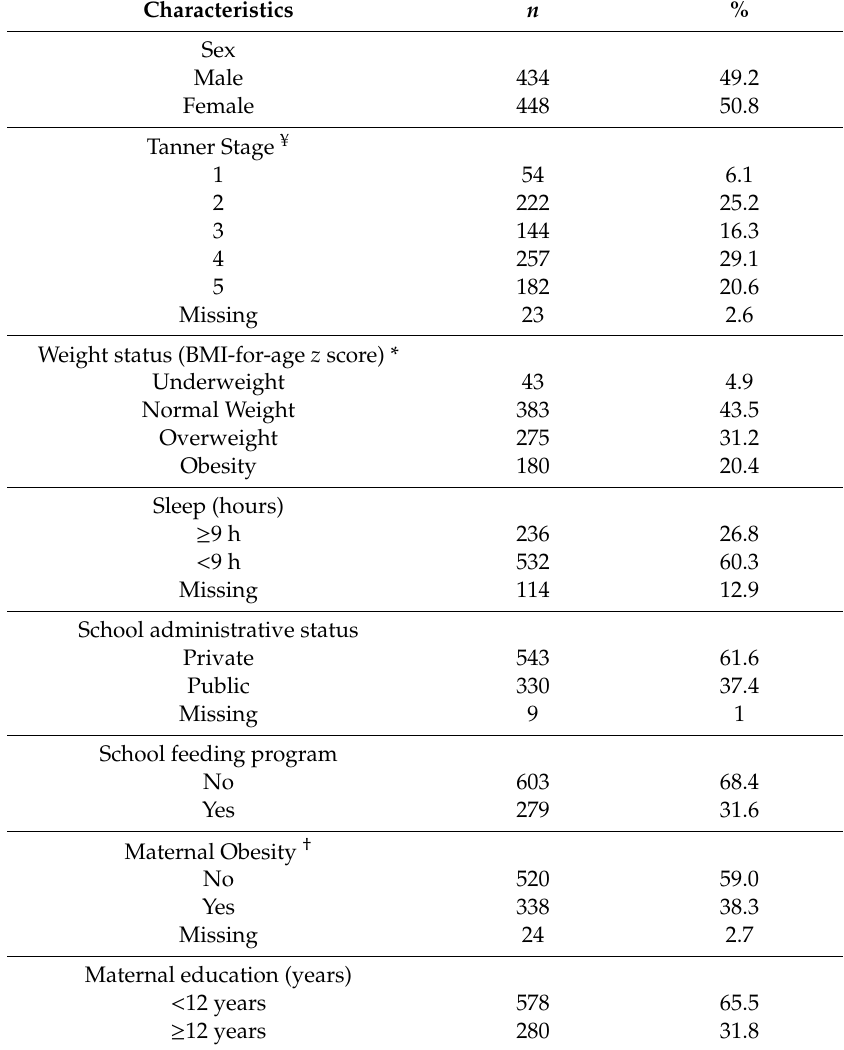
Table 1. Anthropometric, sociodemographic, and maternal characteristics of 882 Chilean adolescents, GOCS Study